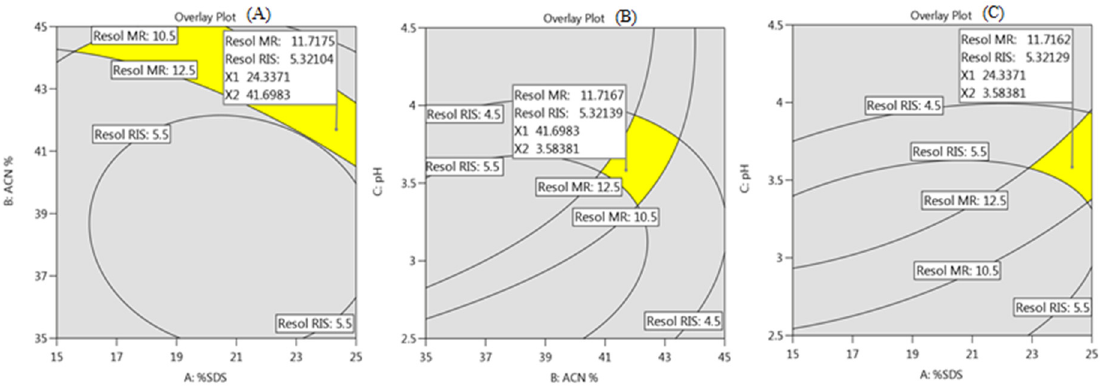
Figure 7. Overlay plot for optimum chromatographic conditions suggested by Design Expert software. % SDS against % of acetonitrile ( A ); % of acetonitrile against mobile phase pH ( B ); %SDS against mobile phase pH ( C ).